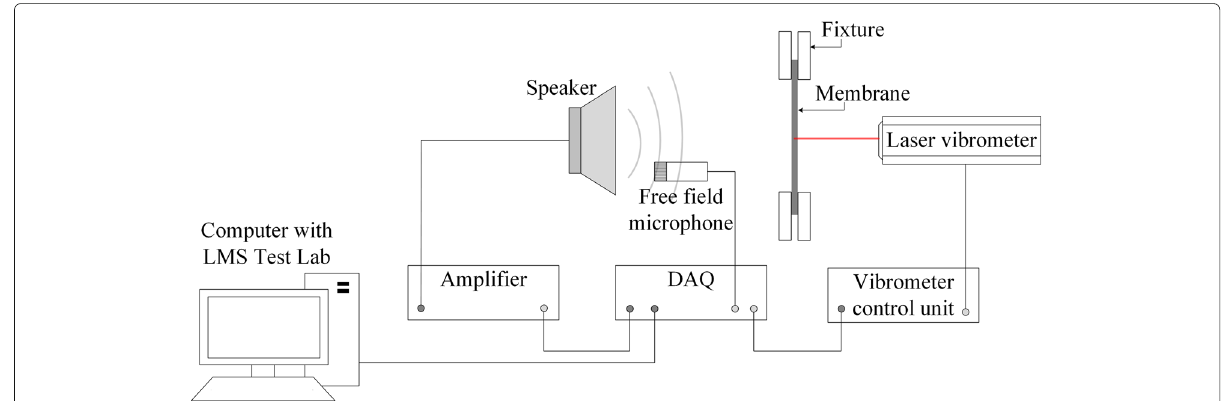
Fig. 9 Schematic layout of the hardware components for EMA